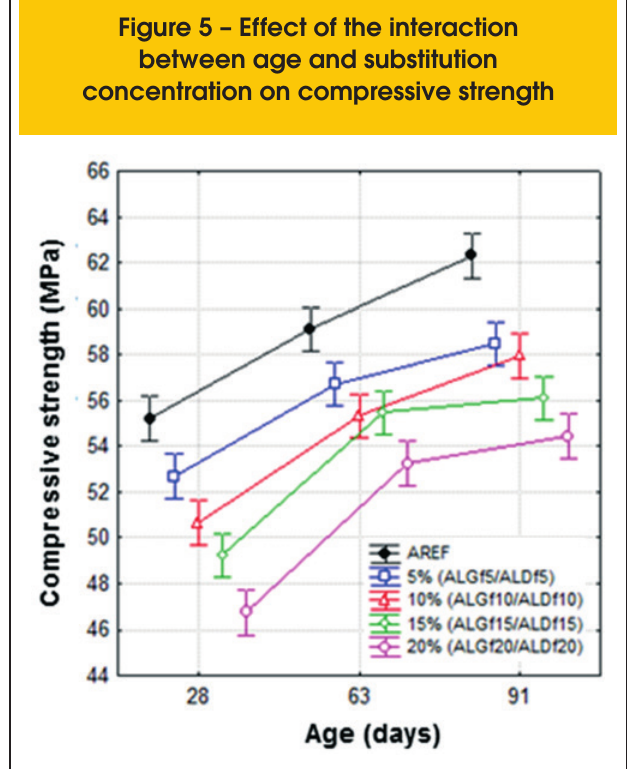
Figure 5 – Effect of the interaction between age and substitution concentration on compressive strength